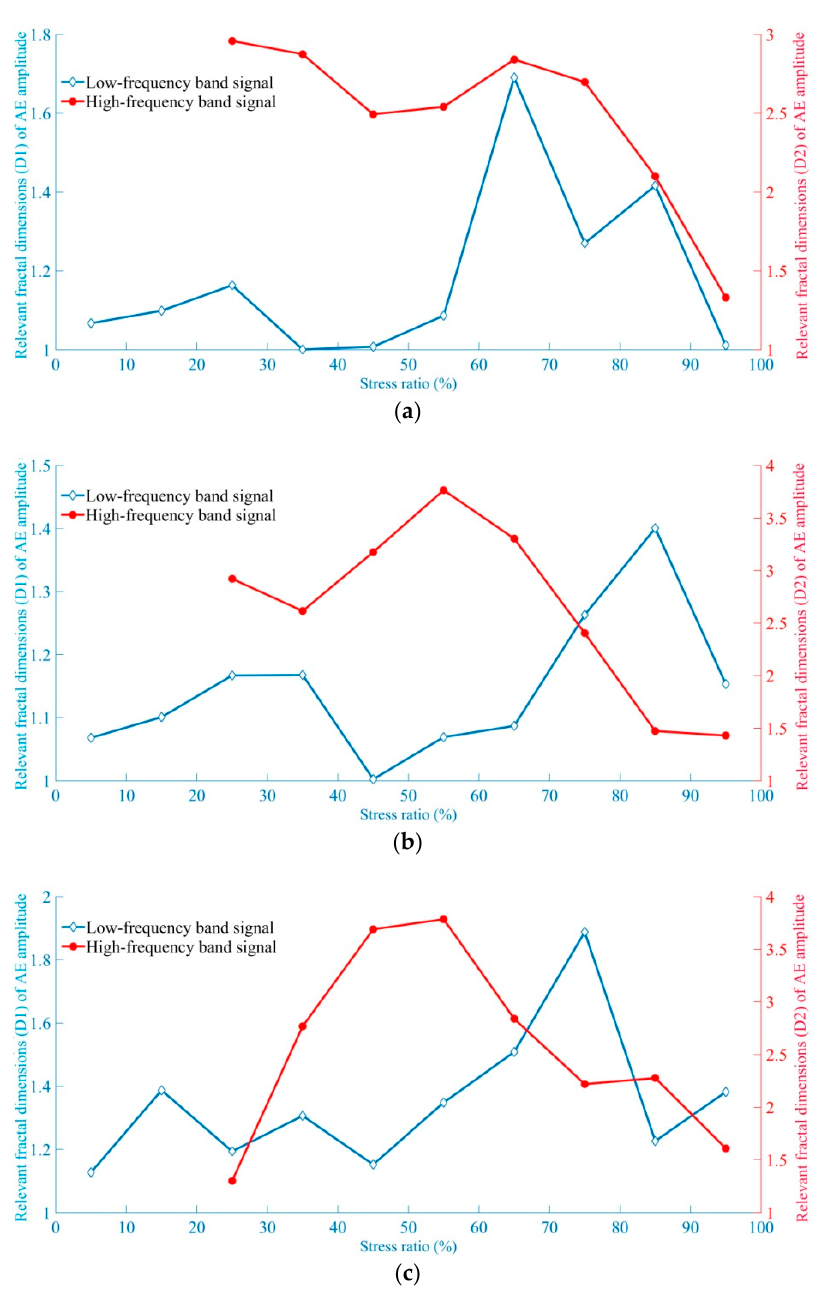
Figure 7. Variation of relevant fractal dimensions of AE amplitude with stress ratio in low- and high-frequency bands. ( a ) X-1 specimen; ( b ) X-3 specimen; ( c ) X-6 specimen.